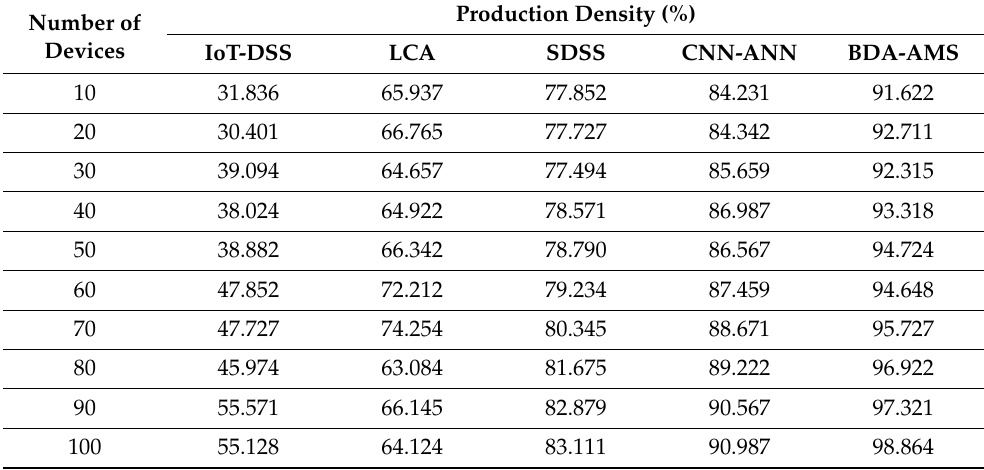
Table 3. Production density ratio